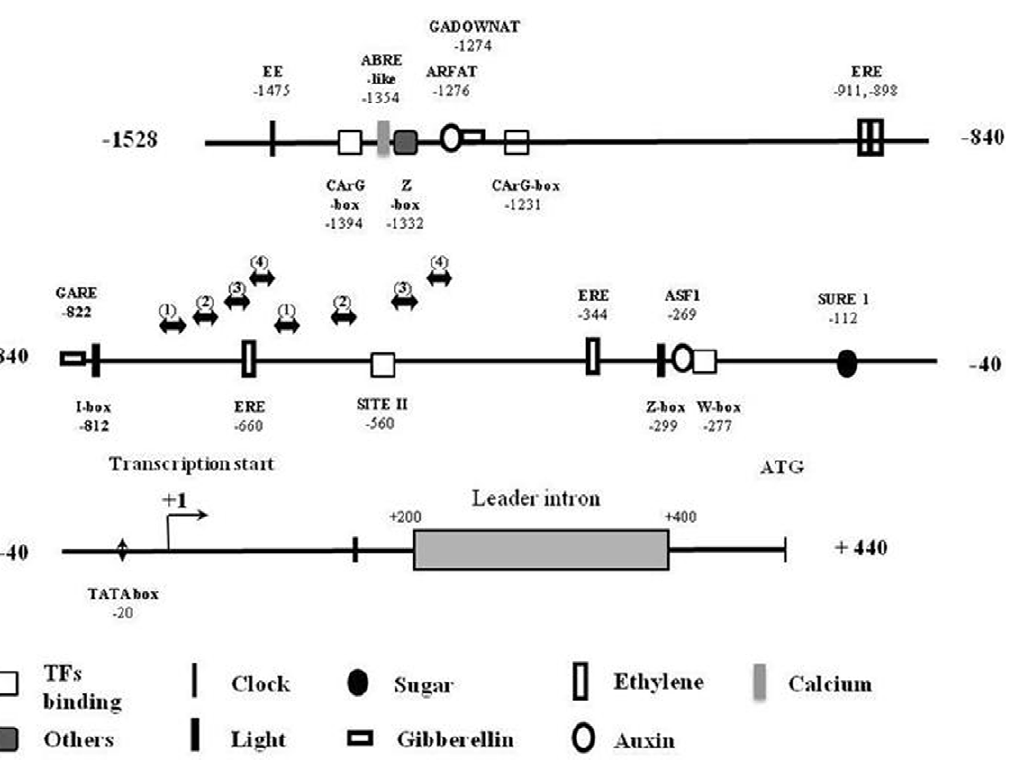
Figure 1. Localization of putative cis -acting elements in SlPPC2 promoter sequence. Sequence was analyzed using PLACE and PlantCARE databases.